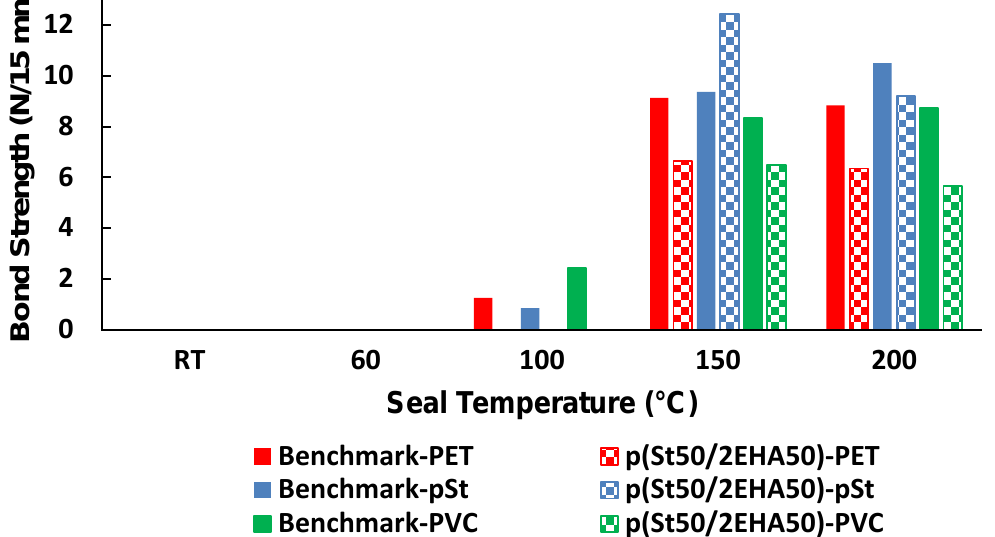
Figure 12. Bond strength of a hard-soft AB block copolymer compared to the benchmark dispersion. Testing of coated papers in sealing to non-coated plastic films: PET (red), pSt (blue), PVC (green) substrates.